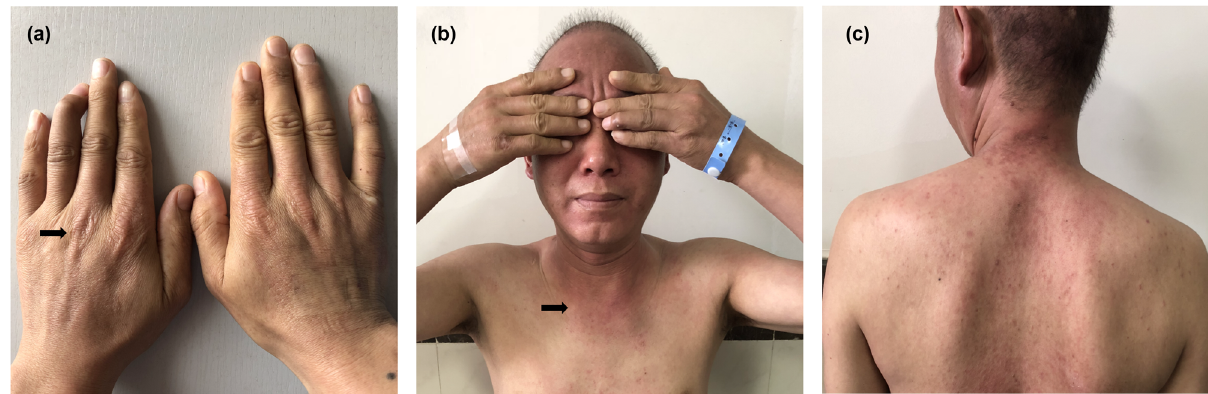
Figure 1: Skin rashes were seen over the dorsal surface of the hands ( Gottron ’ s papules ) ( a ) black arrow, especially over the face and V - neck area ( b ) , black arrow, and the back ( c ) .